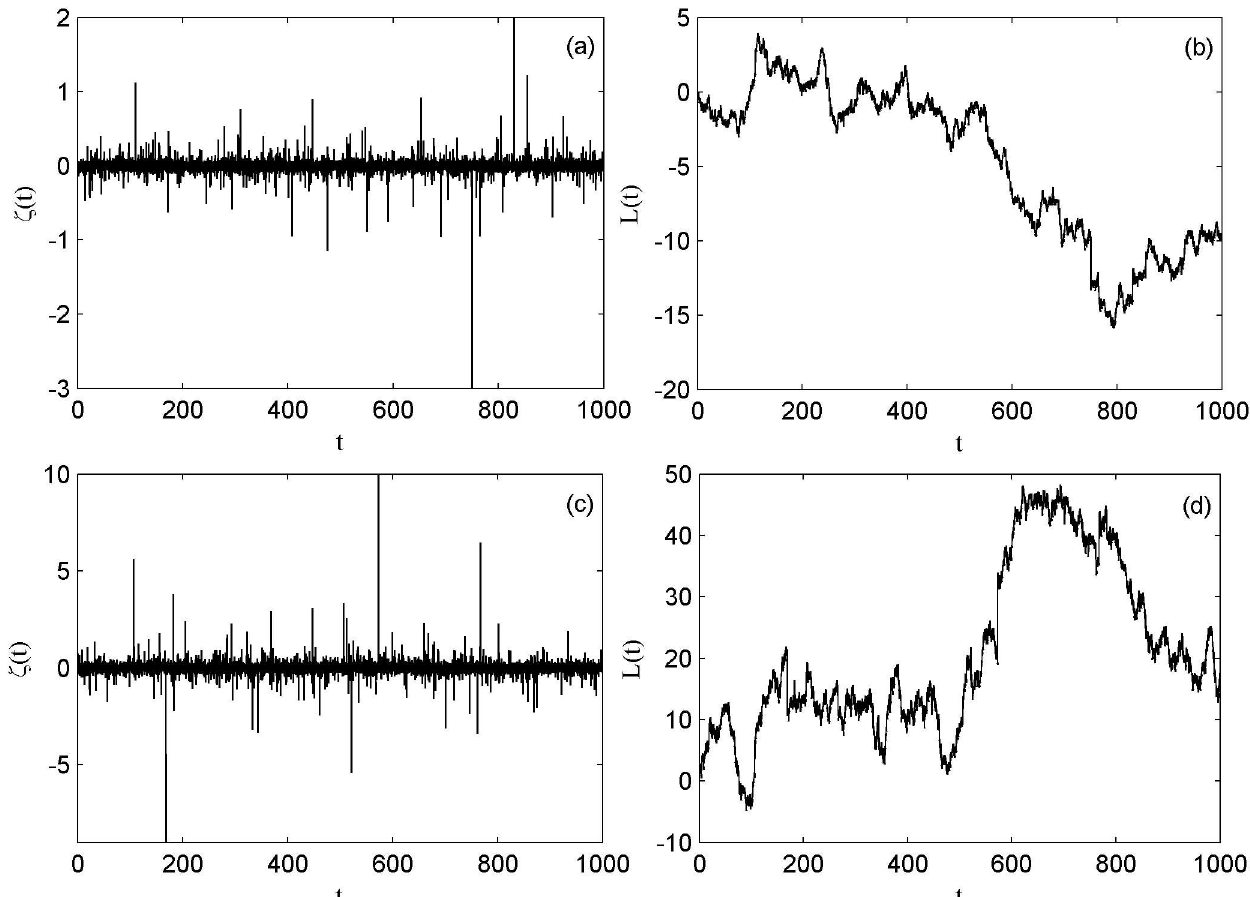
Fig 1. the sequences of Le´vy noise and Le´vy process. (a) Le´vy noise of α = 1.8, β = 0, D = 0.05; (b) Le´vy process of α = 1.8, β = 0, D = 0.05; (c) Le´vy noise of α = 1.8, β = 0, D = 0.5; (d) Le´vy process of α = 1.8, β = 0, D = 0.5.